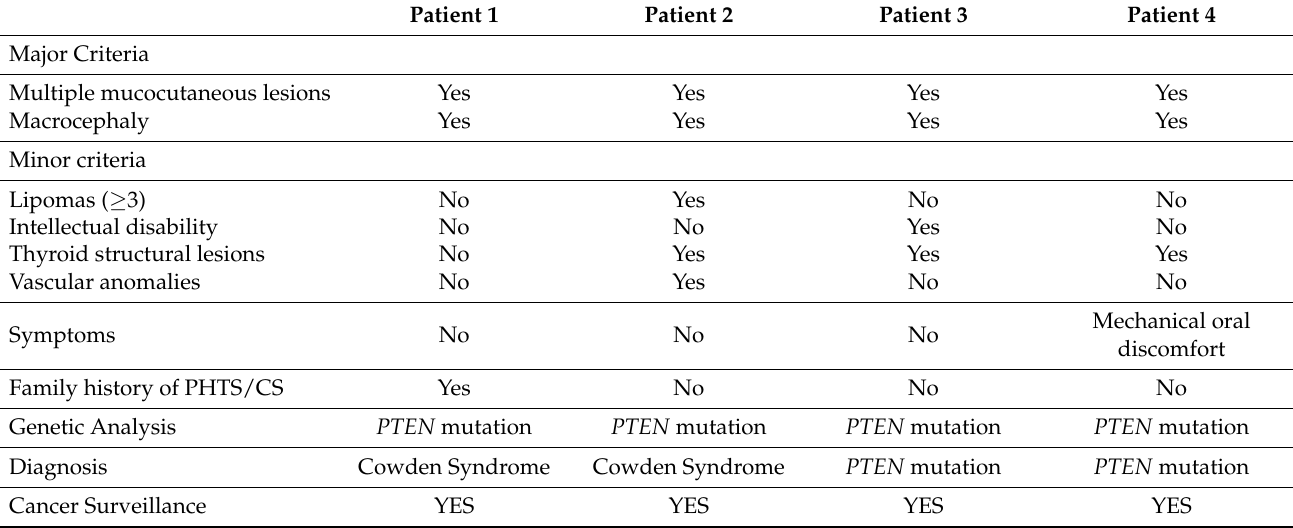
Table 1. CS/PHTS clinical diagnostic criteria and genetic analysis in the reported